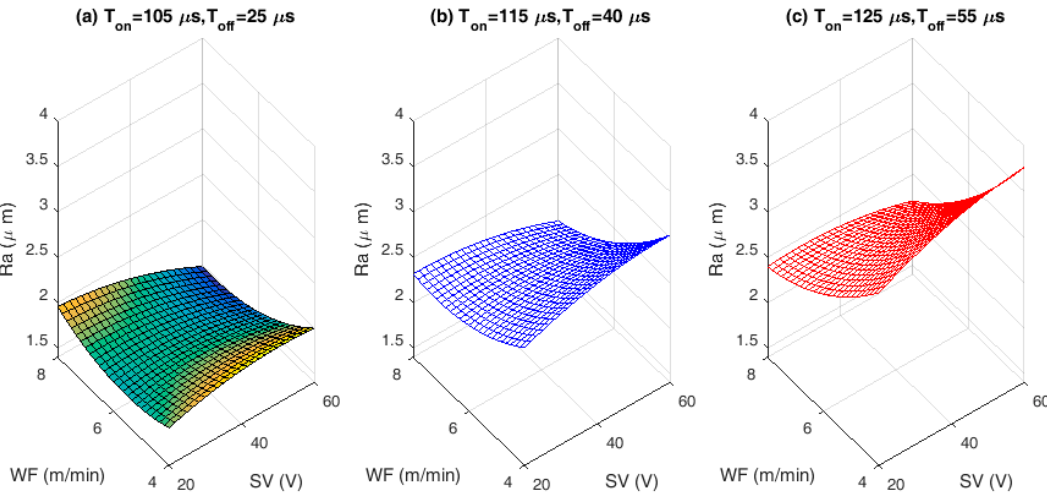
Figure 2. Interaction effects of input process variables on surface roughness (SR): ( a ) Lower hold values of T on and T off . ( b ) Middle hold values of T on and T off . ( c ) Higher hold values of T on and T off .